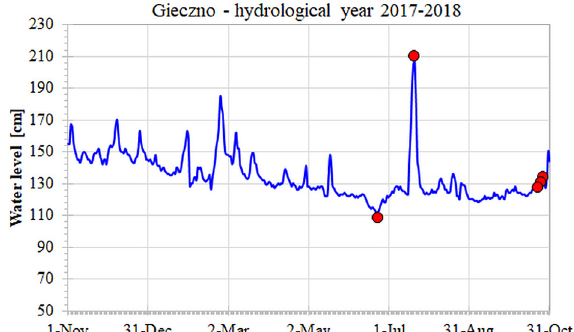
Fig. 2. Water level measured in the gauging station of the IMWM in Gieczno during the 2017–2018 hydrological year. Red dots – days of taking measurements. IMWM – Institute of Meteorology and Water Management.